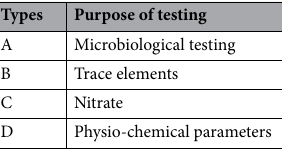
Table 1. Classification of sample